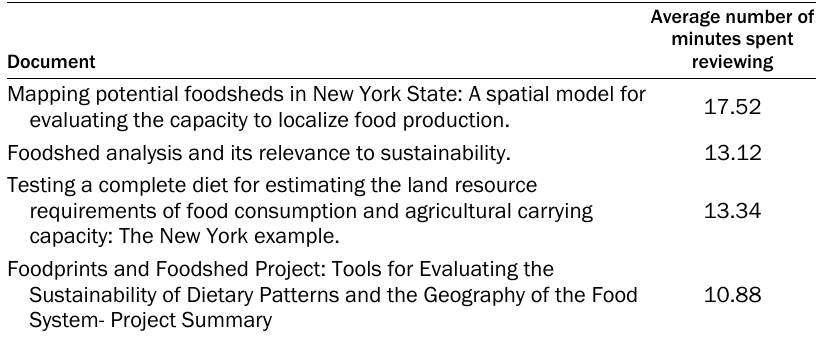
Table 5. Time Spent by Participants Reviewing Materials Prior to the